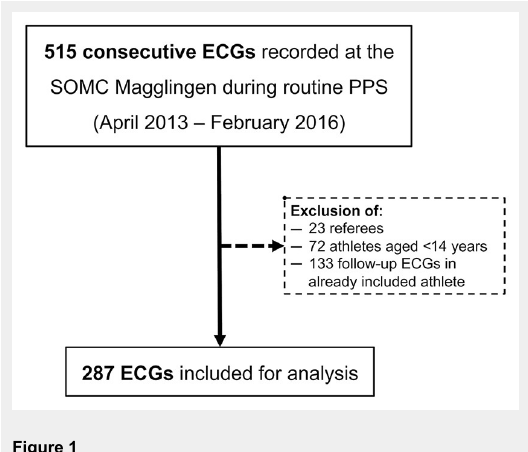
Flow-chart for ECG inclusion during the study period. PPS = pre-participation screening; SOMC = Swiss Olympic Medical Centre.